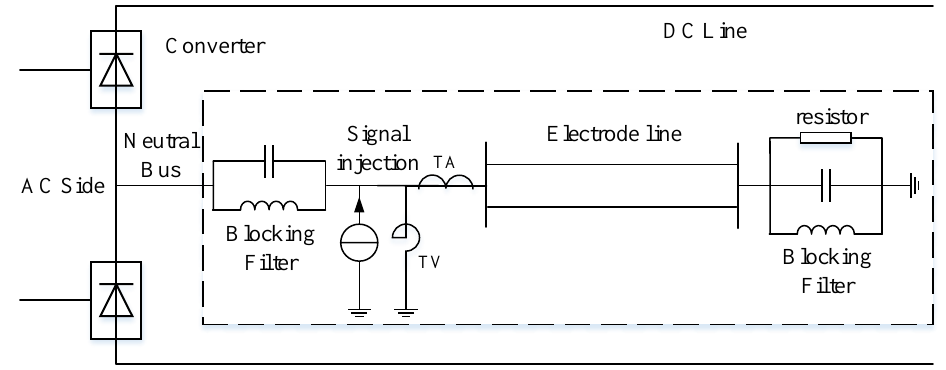
Figure 1. The ELIS device in a typical bipolar UHVDC system.